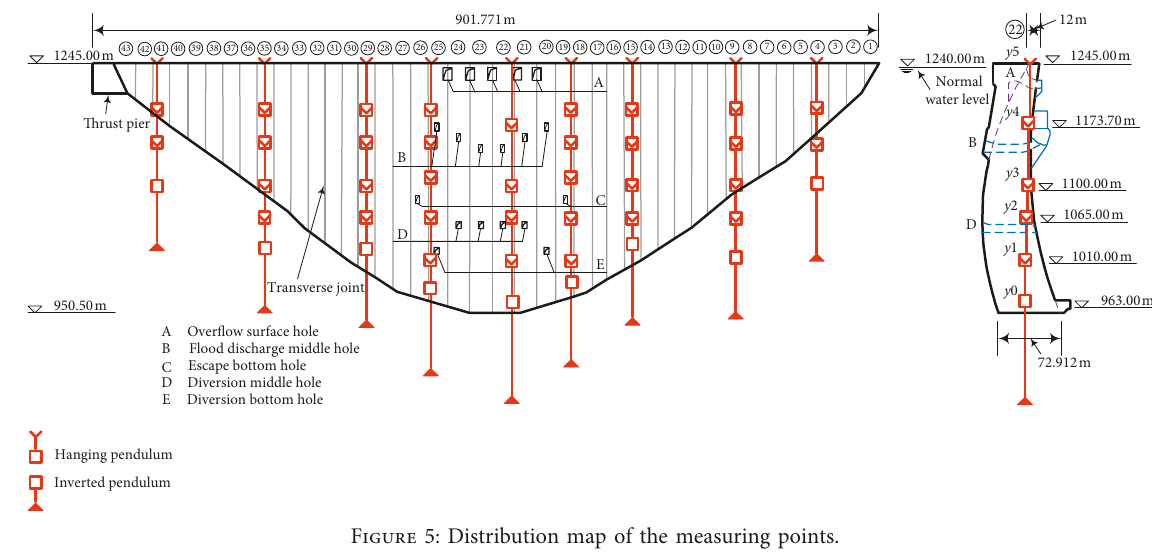
Figure 5: Distribution map of the measuring